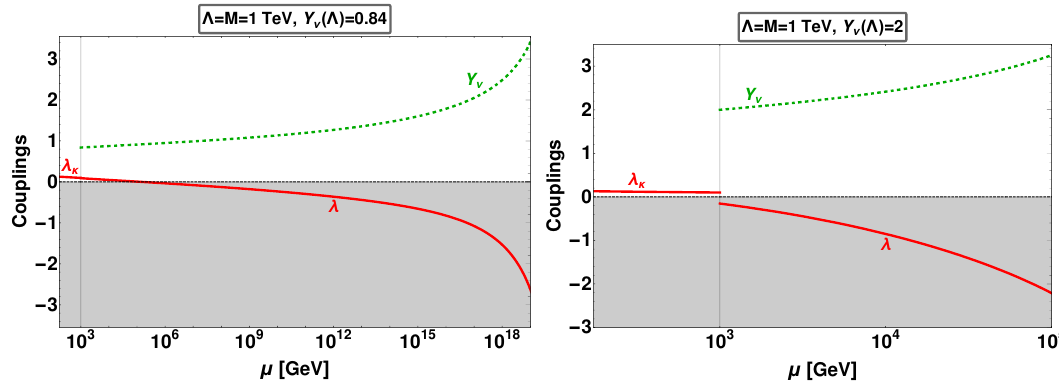
√ 4 π up √ 4 π only